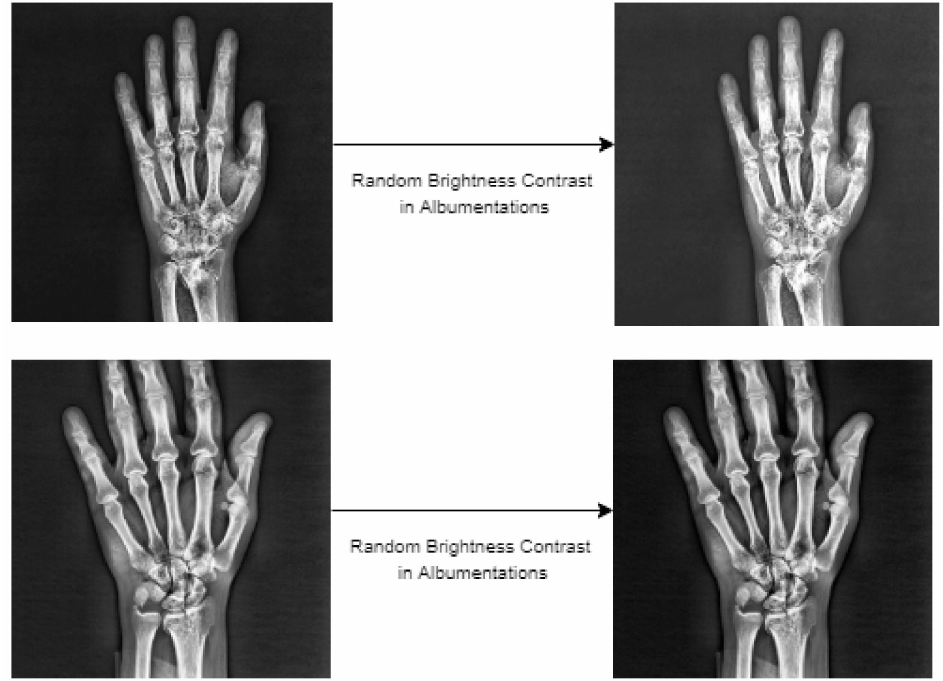
Figure 12. The wrist X-ray images after data